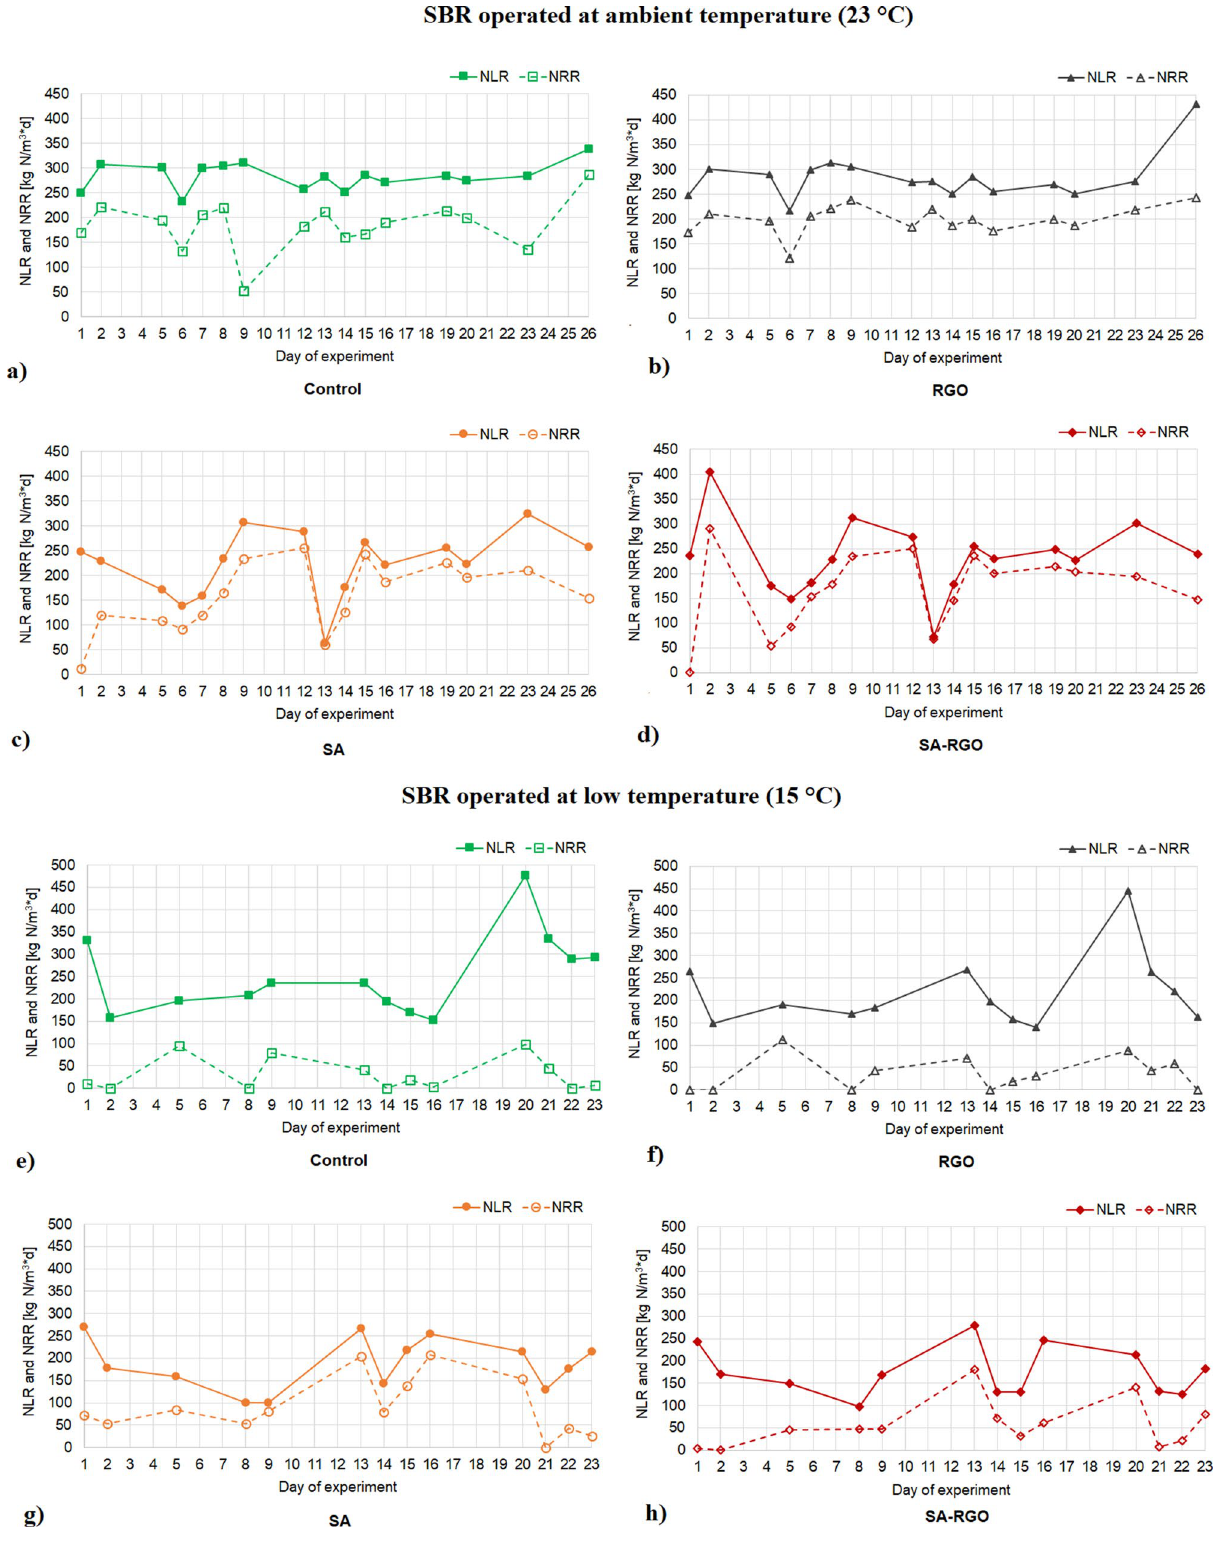
Figure 4. Nitrogen removal rate (NRR) and nitrogen loading rate (NLR) in the SBRs operated at ambient temperature (23 °C) ( a – d ) and at low temperature (15 °C) ( e – h